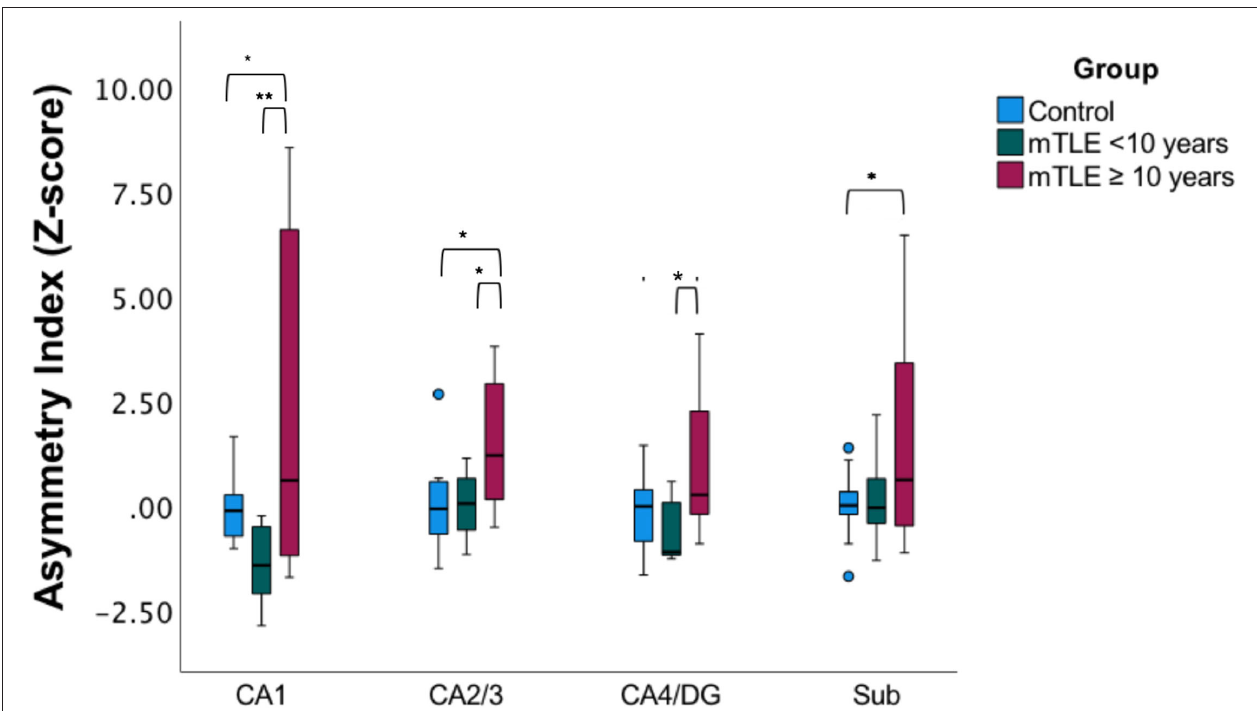
FIGURE 3 | Subfield asymmetry by duration cohorts. Asymmetric index Z-scores across hippocampal subfields in age-matched and gender-matched controls, mTLE cases with a disease duration of < 10 years, (median of the mTLE cohort), and mTLE cases with a disease duration ≥ 10 years. * p < 0.05, ** p < 0.01.